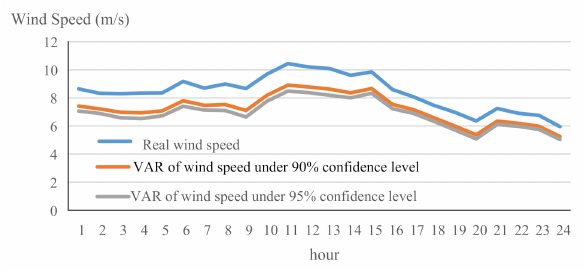
Figure 3. The VAR of wind speed at the confidence levels of 95% and 90%.